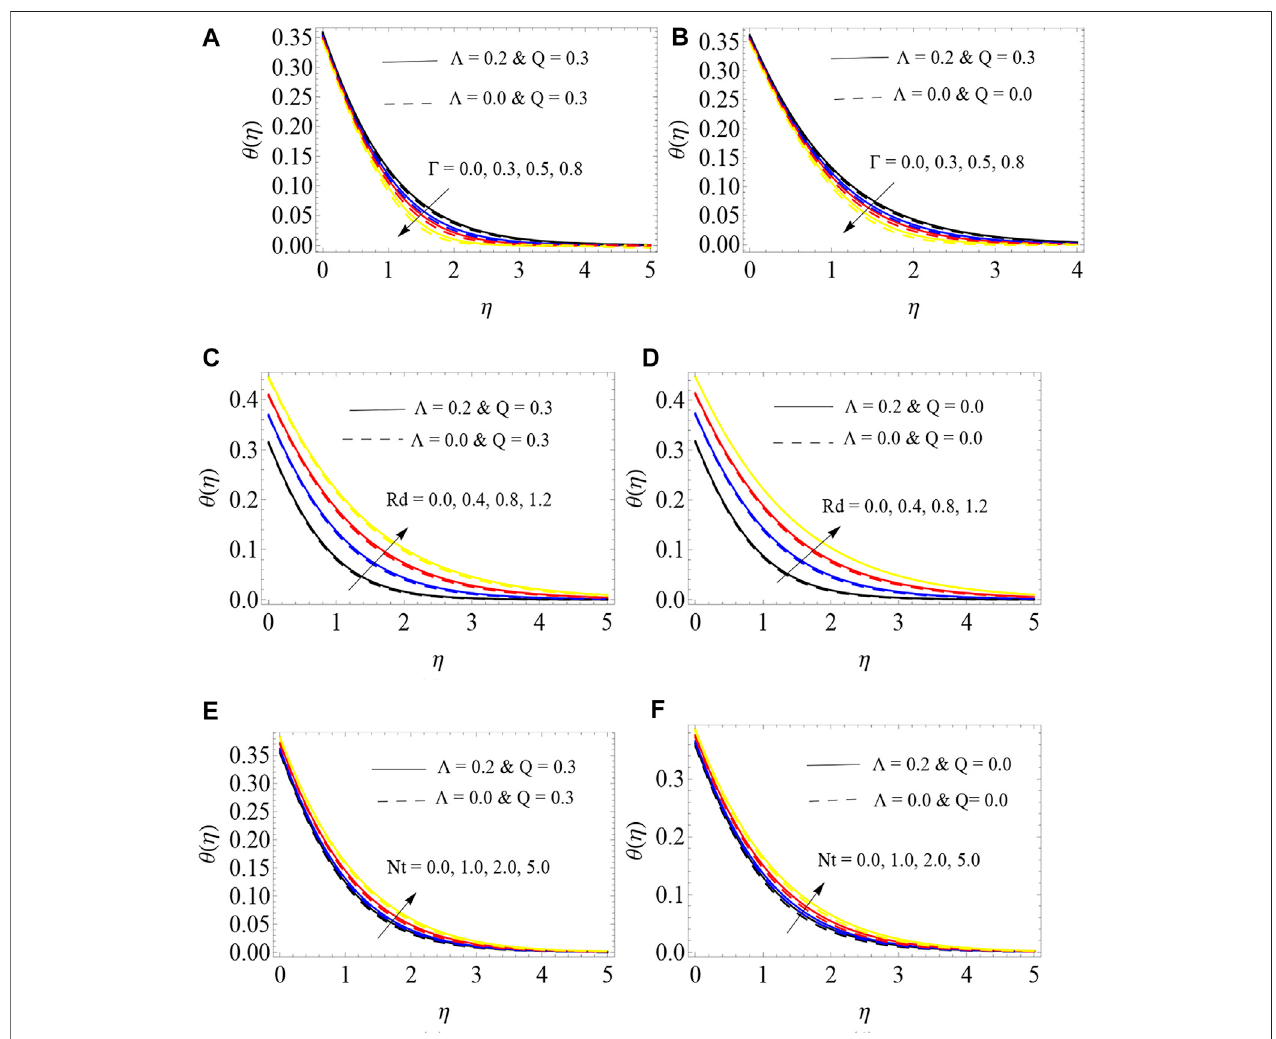
FIGURE 4 | The impact of “ Q, ” “ Λ , ” “ Γ , ” “ Rd, ” and “ Nt ” on temperature pro fi les.